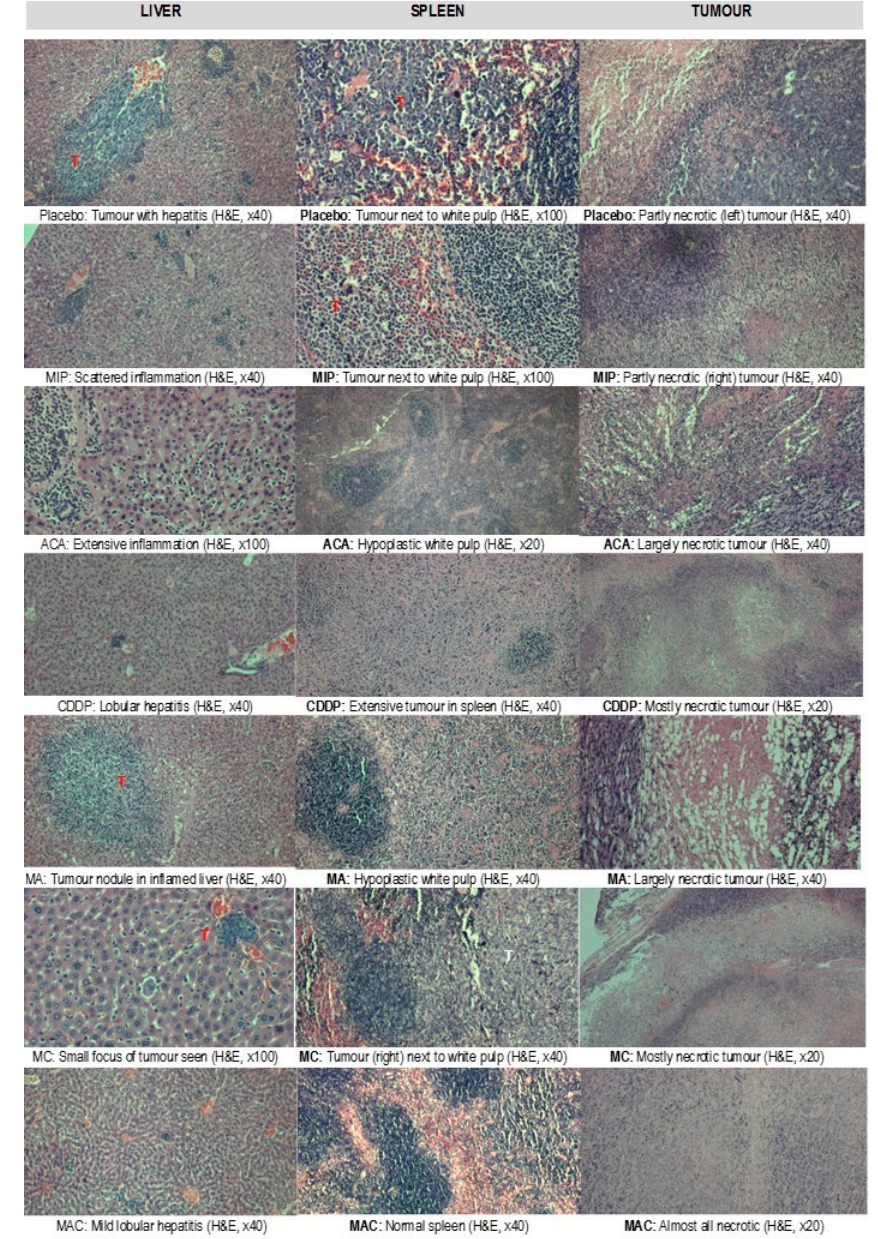
Figure 3. Preliminary toxicity evaluations in the livers, spleens, and tumors (T) of BALB/c mice with breast cancer after treatment with placebo, Mycobacterium indicus pranii (MIP), 1 ′ -S-1 ′ -acetoxychavicol acetate (ACA), cisplatin (CDDP), ACA/MIP (MA), CDDP/MIP (MC), and ACA/MIP/CDDP (MAC). Hematoxylin and eosin stain. × original magnification.